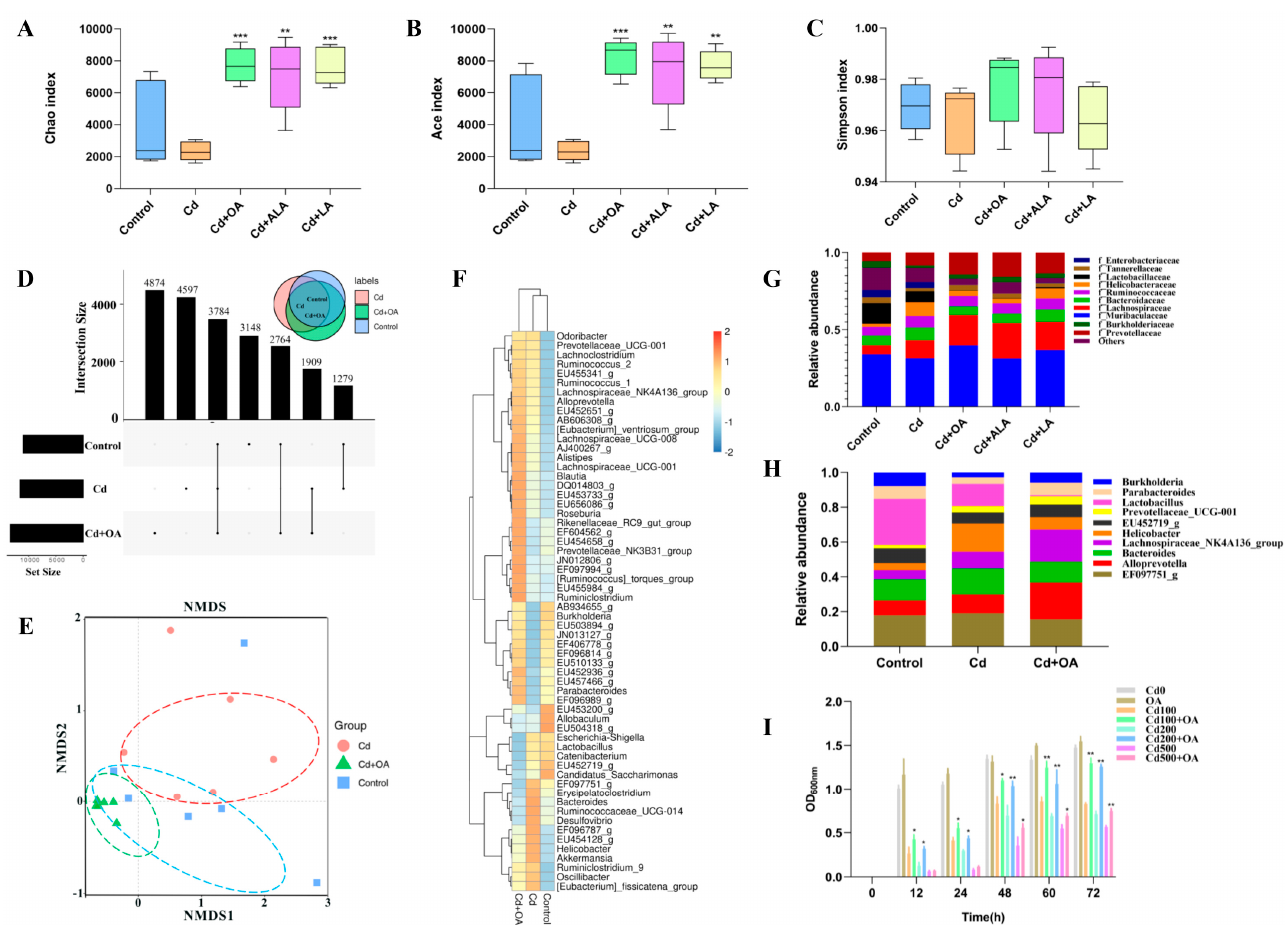
Figure 2. Effects of OA on the gut microbiota. The Alpha diversity of the gut microbial community: Chao ( A ), Ace ( B ), and Simpson ( C ) index. ( D ) The OTUs results at 97% identity level in UpSet diagram of the control, Cd − treated, and OA − treated groups. ( E ) The Beta diversity of the gut microbial community by NMDS maps. ( F ) The microbial abundance heatmap (log10) at the genus level. ( G ) The relative abundance of the top 10 gut microbiota at the family level. ( H ) The relative abundance of the top 10 gut microbiota at the genus level. ( I ) The growth of B. cepacia cultivated in LB broth containing 0, 100, 200, and 500 mg/L of CdCl 2 and 2 mmol/L of OA. * p < 0.05, ** p < 0.01, and *** p < 0.001 versus the corresponding Cd groups.